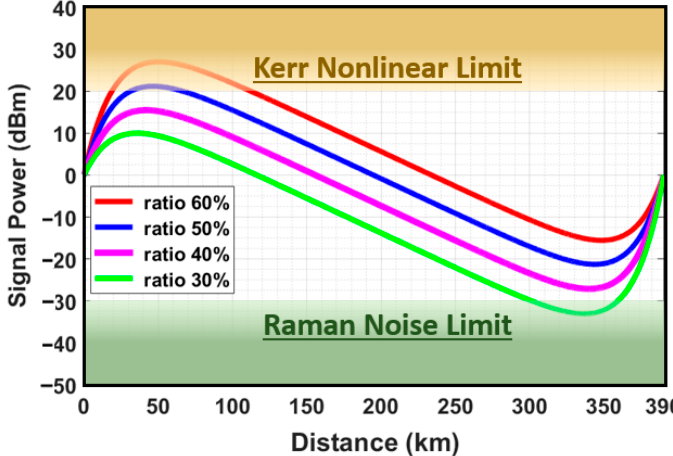
Figure 1. Signal power profile for various Raman pump power ratios, showing the upper and lower signal power boundaries as two limiting factors. Based on [8] with modification to show the profile for propagation distance of 390 km.